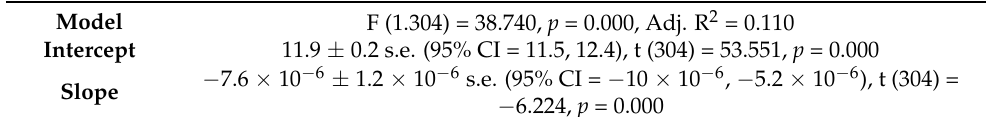
Table 3. Characterization of the regression model relating the abundance ratio 16S rRNA/Hsp70 (dependent variable) to the Hsp70 abundance (independent variable).